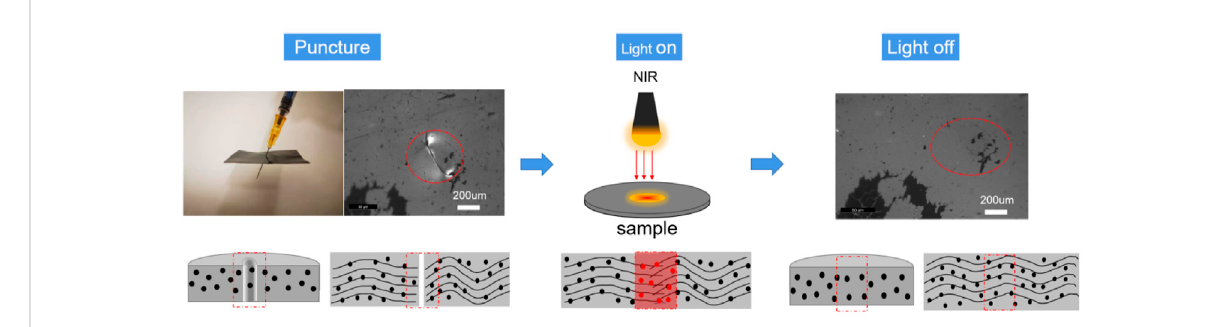
FIGURE 9 The process and mechanisation of self-healing under NIR light.